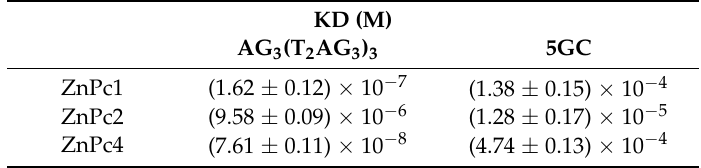
Table 3. Apparent dissociation constants (KD) obtained from UV-Vis